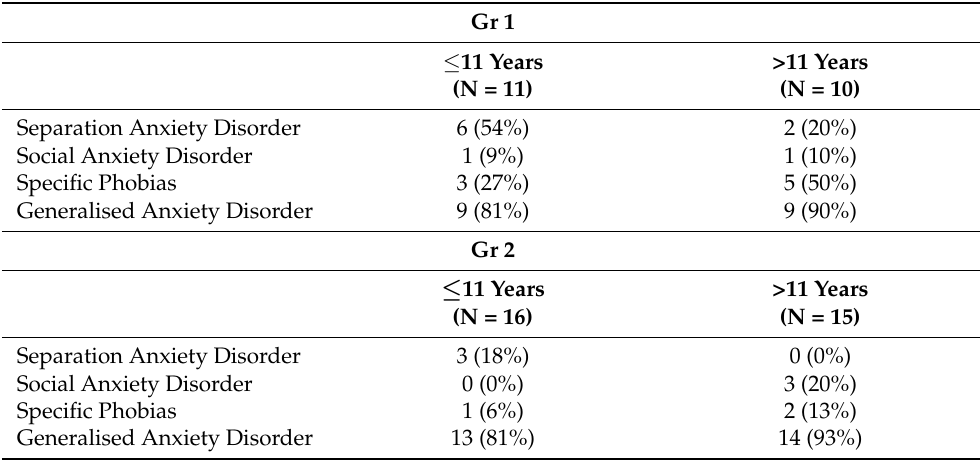
Table 3. Frequencies and percentage frequencies of anxiety disorders (K-SADS PL DSM-5) calculated for Group 1 and Groups based on age differences.